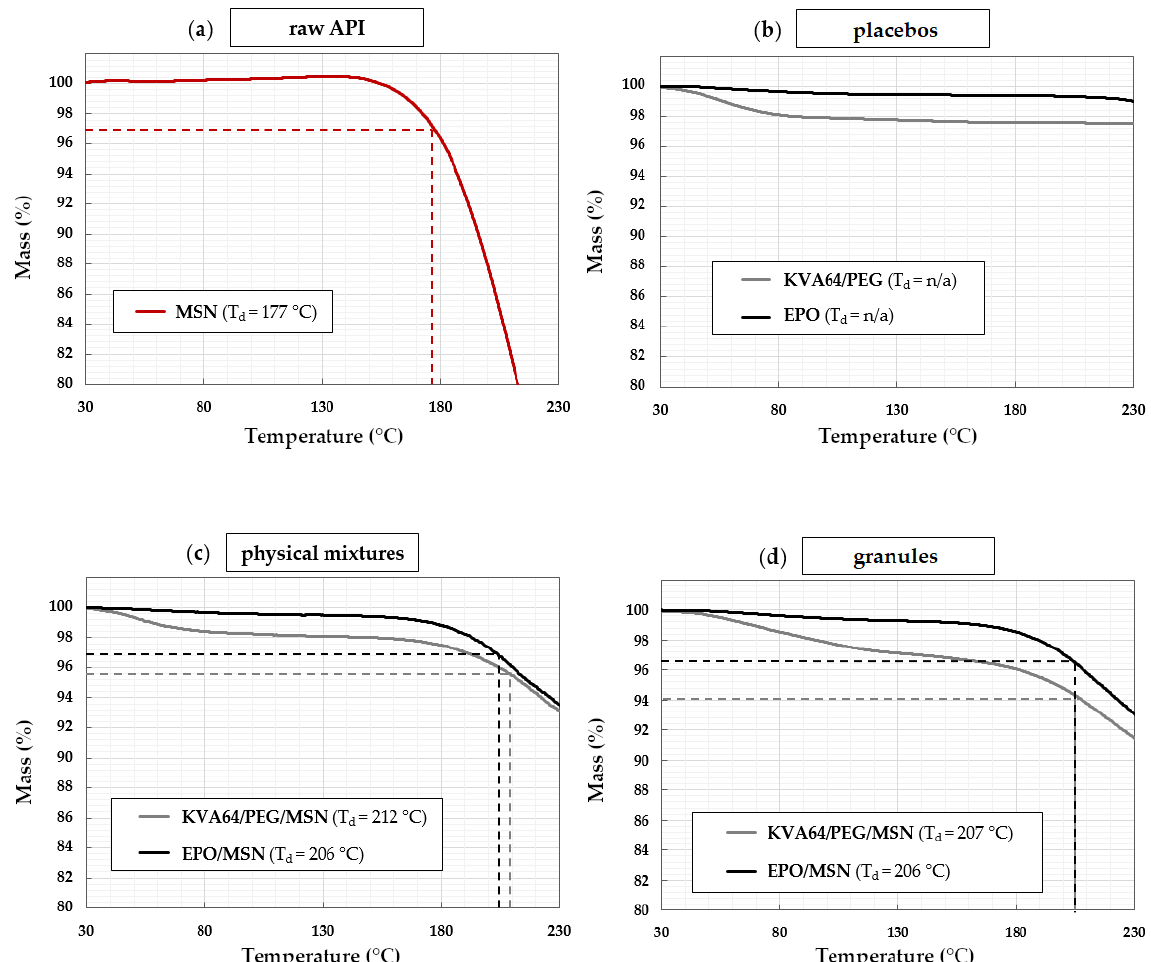
Figure 2. TGA results: ( a ) model drug MSN; ( b ) placebo polymers KVA64/PEG and EPO; ( c ) pre-HME physical mixtures KVA64/PEG/MSN and EPO/MSN; ( d ) post-HME granulated KVA64/PEG/MSN and EPO/MSN.